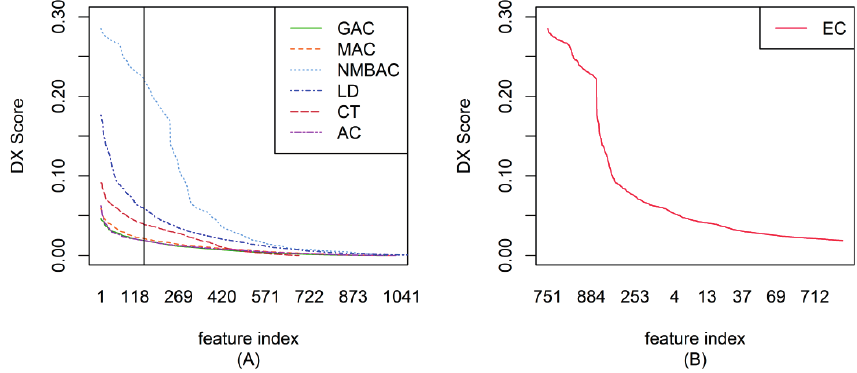
Figure 4. DX score distribution of the different coding methods on the Silver Human dataset. ( A ) The result of six methods; ( B ) The result of EC method.